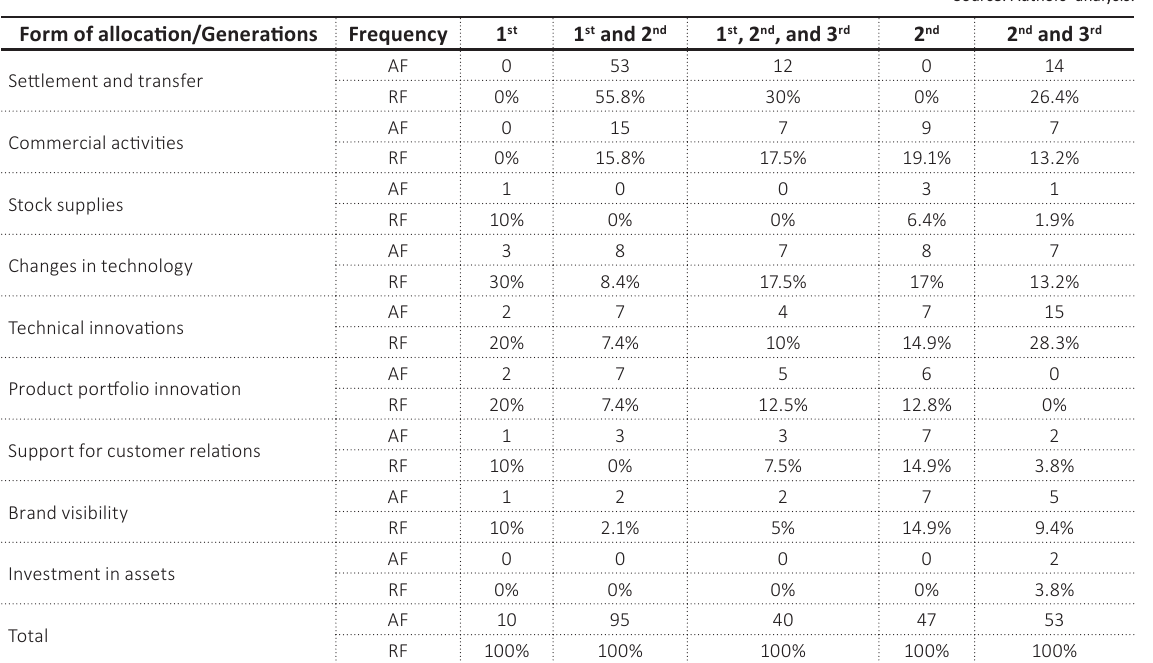
Table 5. Real need for capital concerning the number of generations